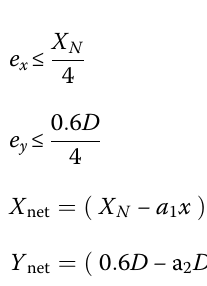
e e x and y are the eccentricity of the center of the open- ing in relation to the center point of the critical diagonal crack, X and Y are the dimensions of solid shear net net zone in the X and Y directions after subtracting the di- mensions of the web opening in the respective direc- x and a D are the opening dimention in X tions, and a 1 2 and Y directions, respectively, measured as indicated in Fig. 2 a. The sign convention adopted as negative when the opening is in the quarter where the load is applied and positive when is located in the quarter with no load. As shown in Fig. 2a the loaded quadrants are the regions lo- cated closer to the load and support bearing blocks. ψ ψ s and w are empirical coefficients assumed as 0.65 and 0.5, respectively. A st ρ ρ s ( s = ð bD (cid:4) 100 Þ ) is the main steel ratio in the concrete P A w deep beam, and ρ w ( ρ w = ð bD (cid:4) 100 Þ ) is the web steel ratio in the concrete deep beam. A w is the area of individual web reinforcement either vertical , horizontal or inclined intersecting with the critical diagonal crack. K Cot β for w = 0.85 for horizontal web reinforcement, vertical web reinforcement, and 1.15 for inclined web reinforcement. β is the critical diagonal crack inclination angle with the horizontal axis.